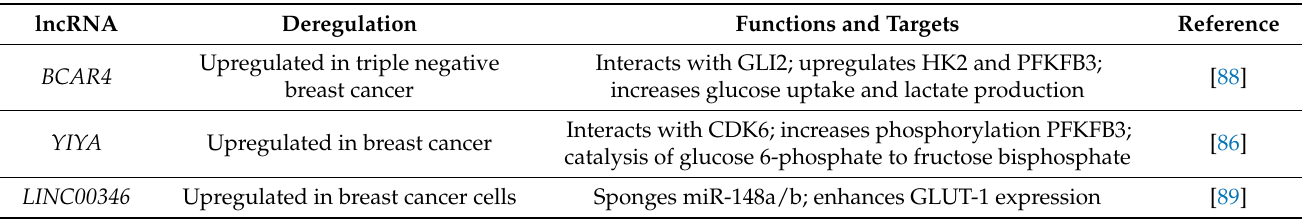
Table 4. Examples of lncRNAs implicated in glucose metabolism alteration in breast